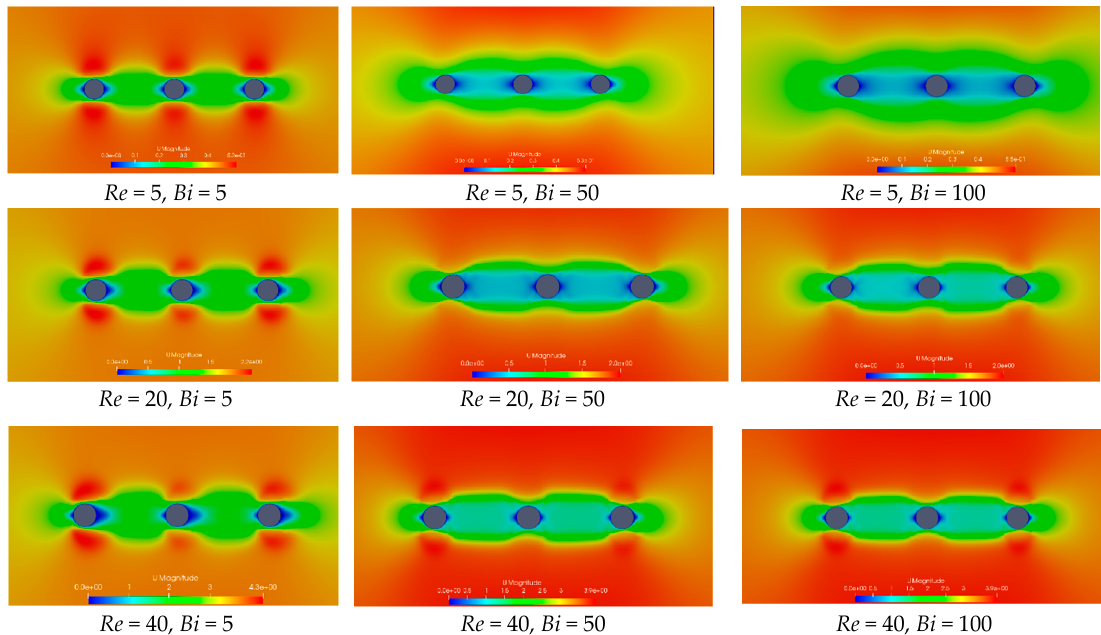
Figure 11. Velocity profile around three cylinder in three Bingham numbers (Bi = 5, 50 and 100) and three Reynolds number (Re = 5, 20 and 40) where d = 4.0 D.